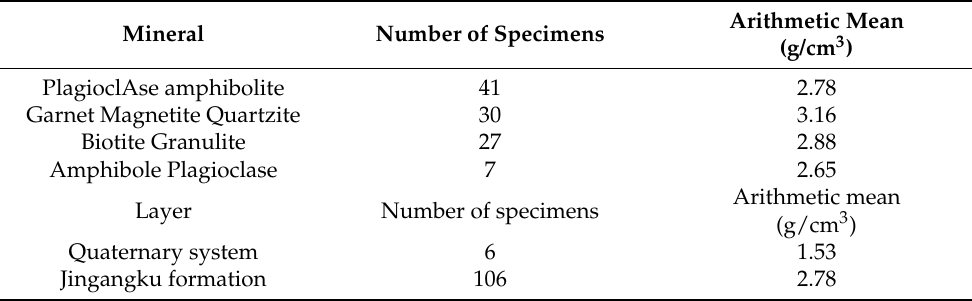
Table 1. Density parameters of minerals and rocks in the Shihe area.